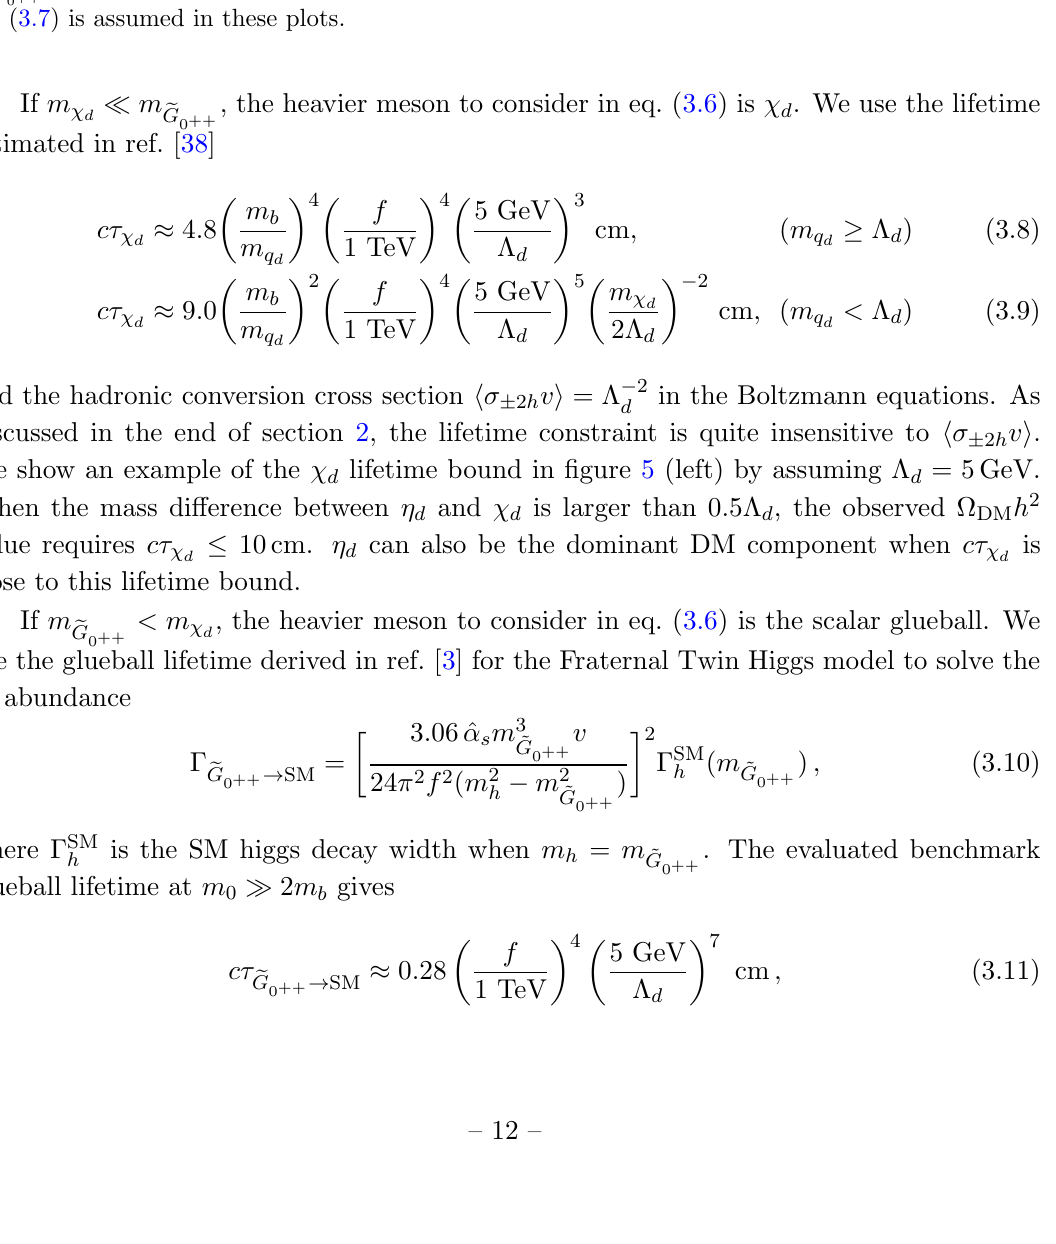
= 35 GeV before d